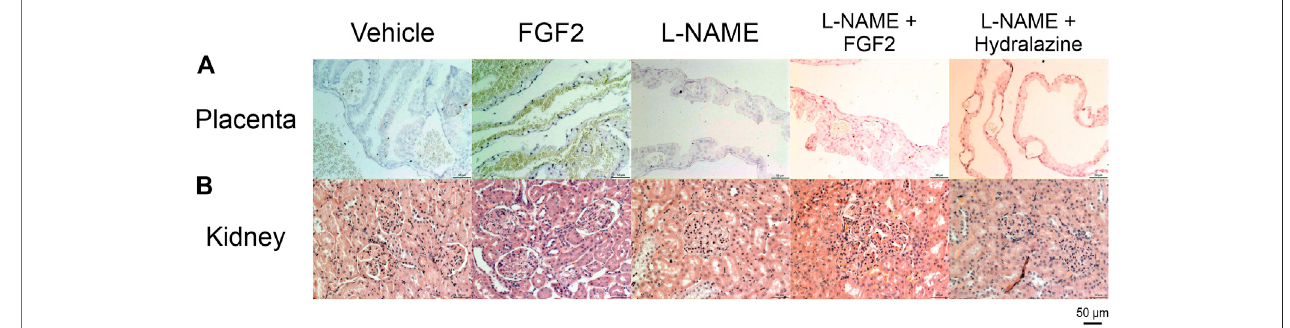
FIGURE7| Placentaand kidneyhistology (immunohistochemistry against factor VIII and PAS). (A) Placental sections from allexperimentalgroups immunostained for factor VIII. (B) kidney sections from all experimental group stained with PAS stain. All the slides were visualized at 10x and 20x with an Axiocam 503 color camera, attached to an Axio Observer Z1 motorized inverted fl uorescence